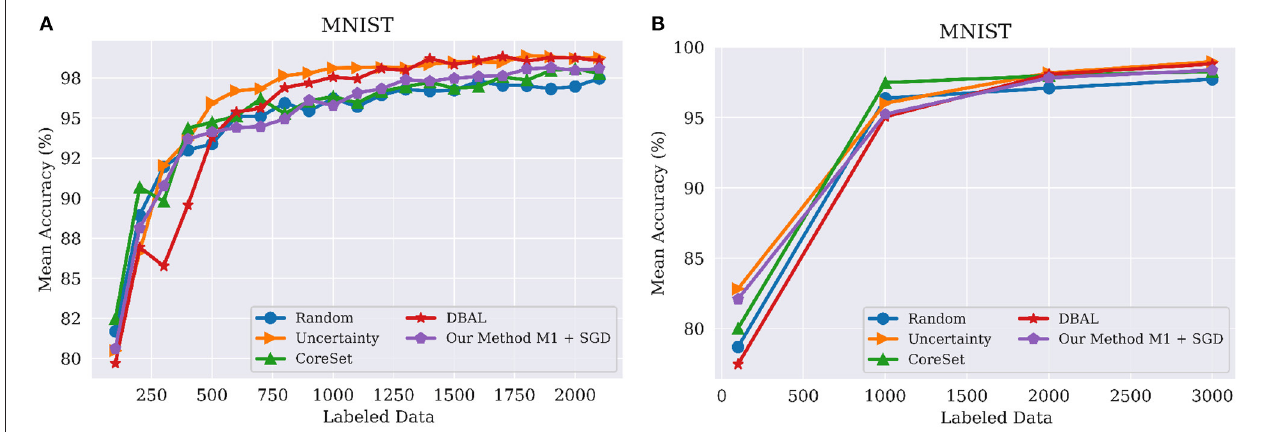
FIGURE 2 | Performance on MNIST classification tasks using different query sizes for model M 1 . (A) Query batch size of 100; (B) Query batch size of 1,000 compared to Core-set (Sener and Savarese, 2017), DBAL (Gal et al., 2017), Random Sampling, and Uncertainty Sampling. M1 indicates our model with Encoder and Classifier. Best visible in color. Prior results adapted from Sinha et al.